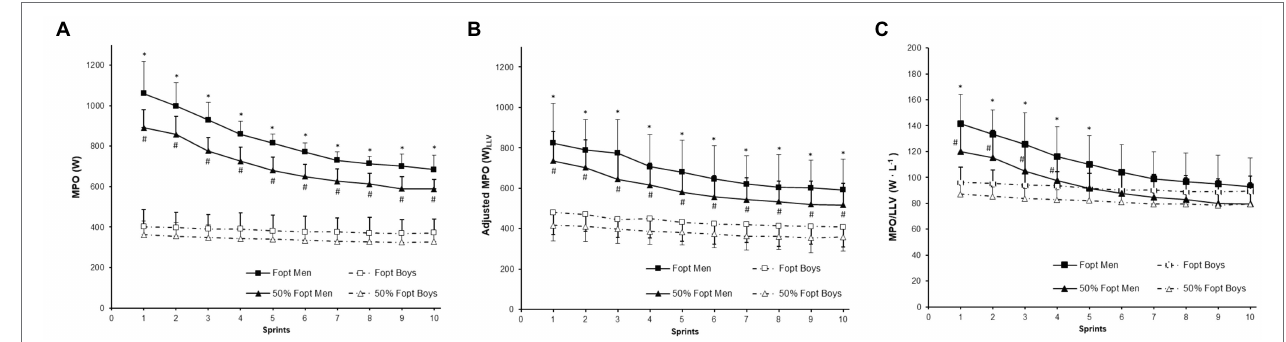
FIGURE 3 | Mean power output in 10 repeated cycling sprints at light and heavy resistive loads in boys and men. MPO in (A) absolute values, W, (B) adjusted for LLV, and (C) conventional ratio-scaling (W L LLV − 1 ). *Significantly different between boys and men in the heavy-load condition; p < 0.05. # Significantly different between boys and men in the light-load condition; p < 0.05.